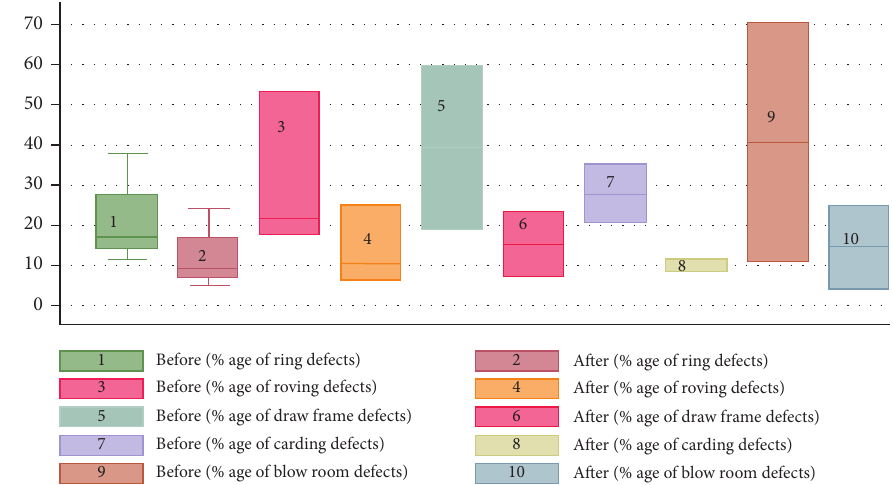
Figure 5: Percentage of defect reduction after preventive action is